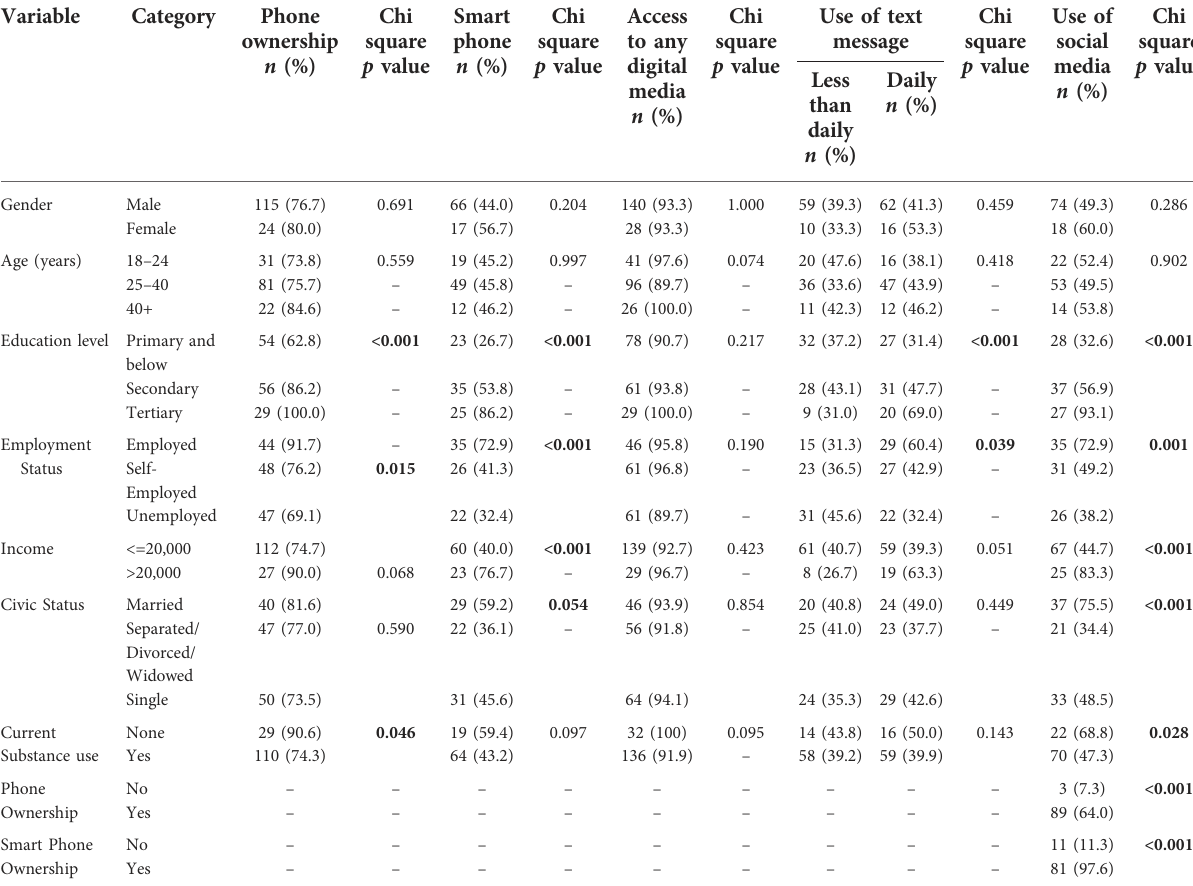
TABLE 5 Factors associated with mobile phone ownership and other digital use on bivariate